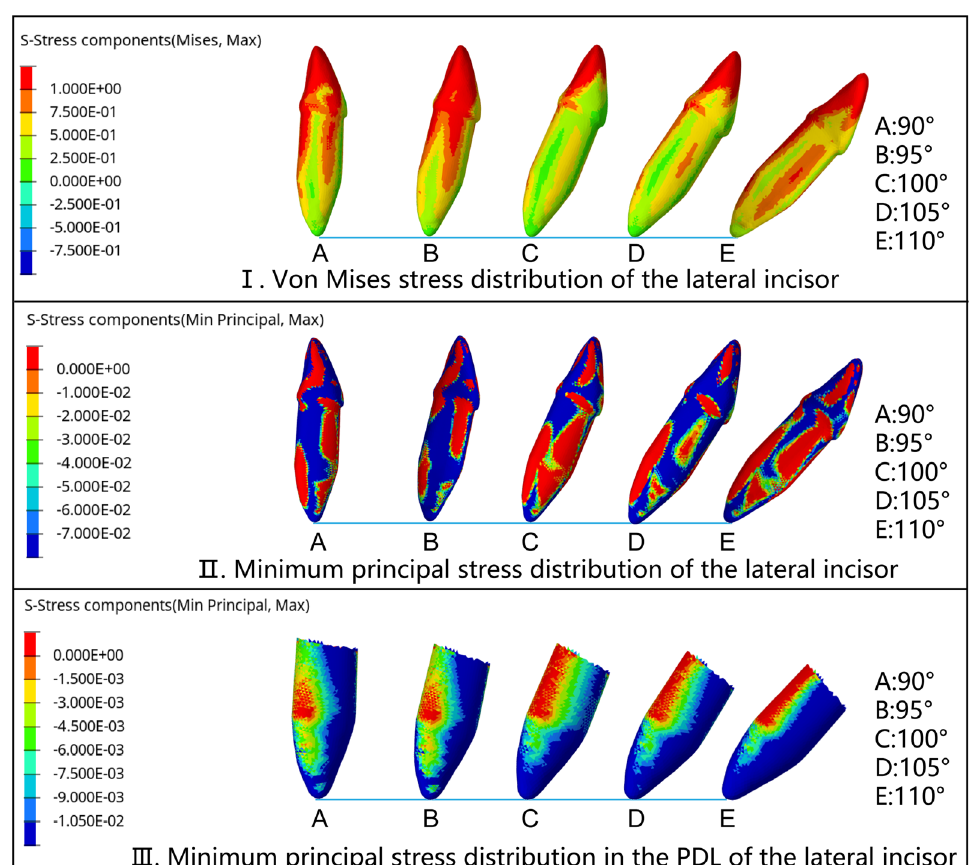
Fig. 6 Stress distribution of lateral incisors with different IMPA during the intrusion by 0.2 mm. The sequence is A (90°), B (95°), C (100°), D (105°), and E (110°). The stress distribution of the lateral incisor was similar to that of the central incisor. I . The von Mises stress distribution of the lateral incisor was similar to that of the central incisor, but the average stress value was larger. II . The minimum principal stress distribution of the lateral incisor was similar to that of the central incisor, the value of compressive stress was smaller, and the distribution on the labial and lingual sides was more symmetrical. III . The minimum principal stress distribution in the PDL of the lateral incisor was concentrated on apex and labial surface, and the average compressive value was larger than that of central